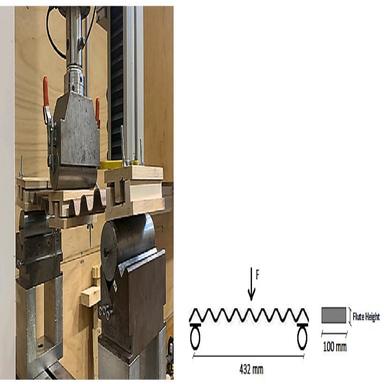
Transverse bending test on corrugated panel with use of anti-crushing devices.